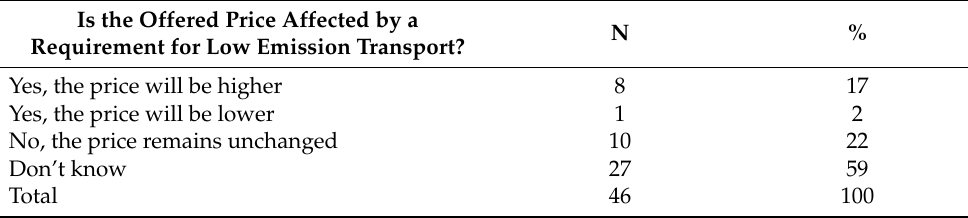
Table 8. Procurers’ assessment of consequences for offered price in